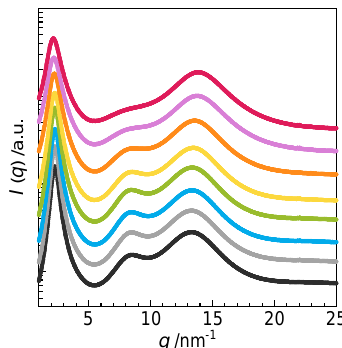
Figure 6. WAXS profiles of nonionic surfactant C 12 EO 6 in amphiphilic gemini ionic liquid 2C 12 (2-O-2) NTf 2 at 25 ◦ C: 0 (black • ), 10 (gray • ), 50 (sky blue • ), 100 (yellow green • ), 250 (yellow • ), 500 (orange • ), 750 (pink • ), and 1000 mmol dm − 3 (red •